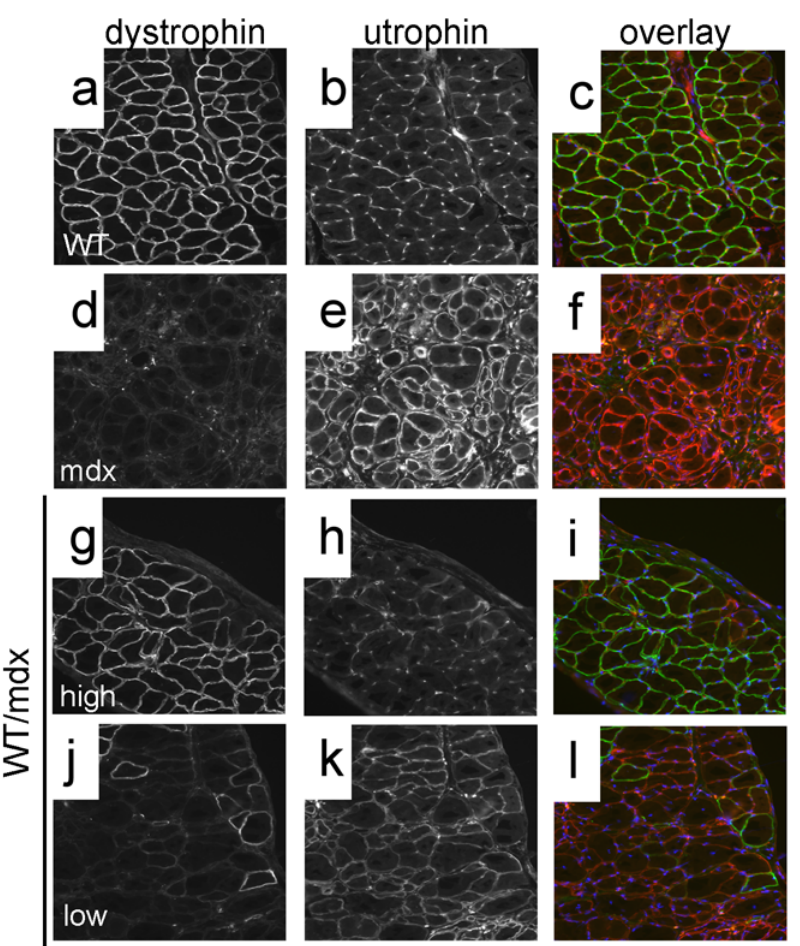
Figure 5. WT/mdx chimeric muscle is composed of dystrophin-positive (utrophin-negative) and dystrophin-negative (utrophin- positive) fibers. a–l, diaphragms from WT (a–c), mdx (d–f) and 10–30% WT/mdx chimeric (g–l) mice were sectioned and stained for dystrophin (a,d,g,j) and utrophin (b,e,h,k). (c,f,i,l): dystrophin (green)/utrophin (red) overlay. Note absence of yellow (overlay of green and red), indicating no dystrophin/utrophin co-localization. g–i, areas of high dystrophin; j–l, areas of low dystrophin in the diaphragm of the same mouse. Magnification: 200 6 . Experiments were performed with pectoralis and diaphragm muscles of 3 animals (n=3) per group (WT, 10–30% WT/mdx and mdx). normal (Table S2: unchanged, WT/mdx vs WT). Schwann processes, which guide the innervation of a newly regenerated fiber, are compromised in the mdx muscle [38]. Corrections outside the skeletal fibers were also apparent. Unlike mdx, which are lean, WT/mdx chimeric mice with 10–30% WT ESC chimerism had improved fat mass (abdominal fat weight/total weight of WTs: 4.2 6 1.5%, of mdx mice: 1.2 6 0.4%, of 10–30%